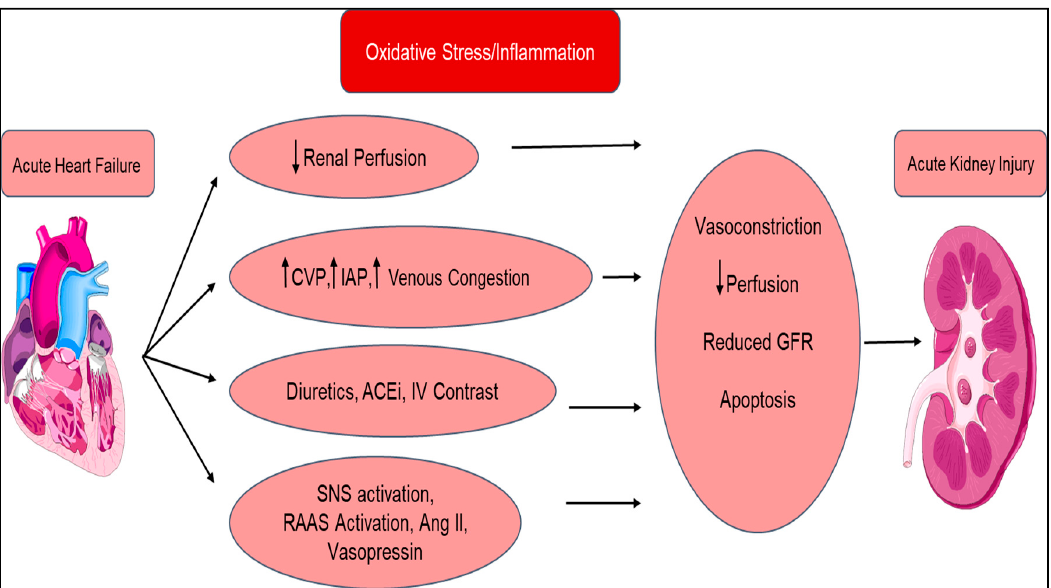
Figure 2. Pathophysiology of acute cardiorenal syndrome (type 1): mechanism of how acute heart failure leads to acute kidney injury (AKI) due to inadequate renal perfusion, endothelial activation, and cytokine production, which activates the RAAS, salt and water imbalance, and vasoconstriction, further exacerbating AKI. CVP = central venous pressure; IAP = intraabdominal pressure; ACEi =